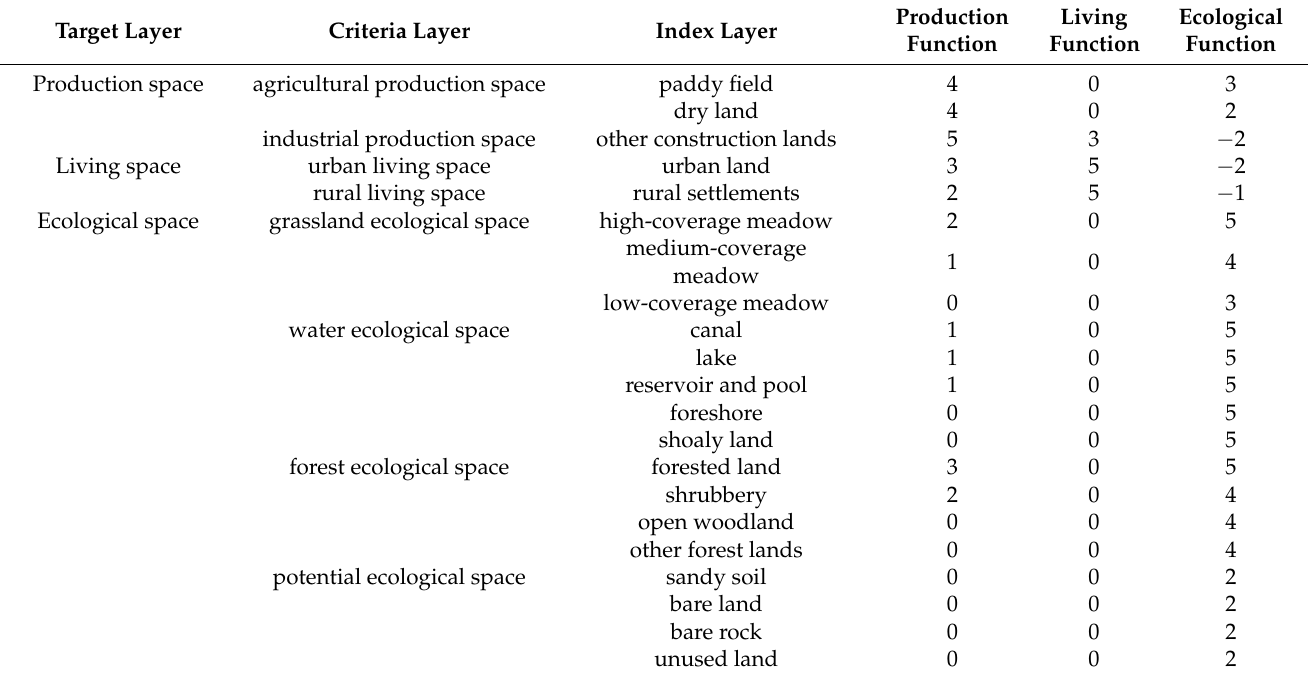
Table 1. The PLES assessment of each land use